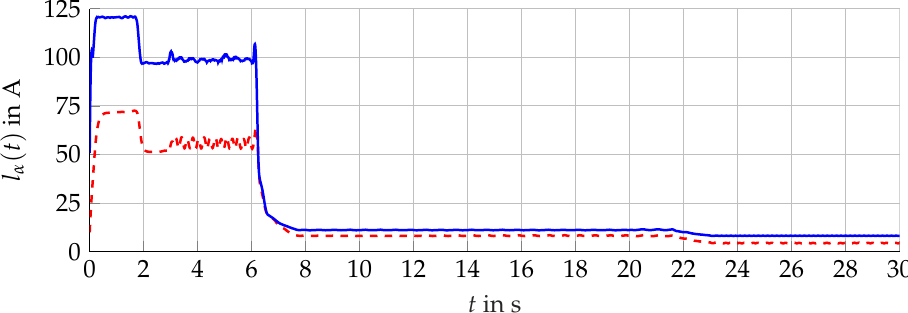
Figure 19. Interval width l α ( t ) of the bundle of observers B (red, dashed) compared with the single interval observer ∑ (blue, solid) of the scenario with measurement REF